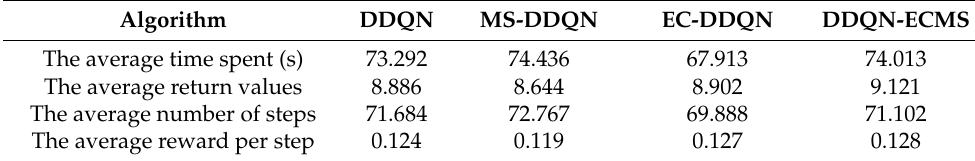
Table 3. Performance comparison of four different algorithms in a random position